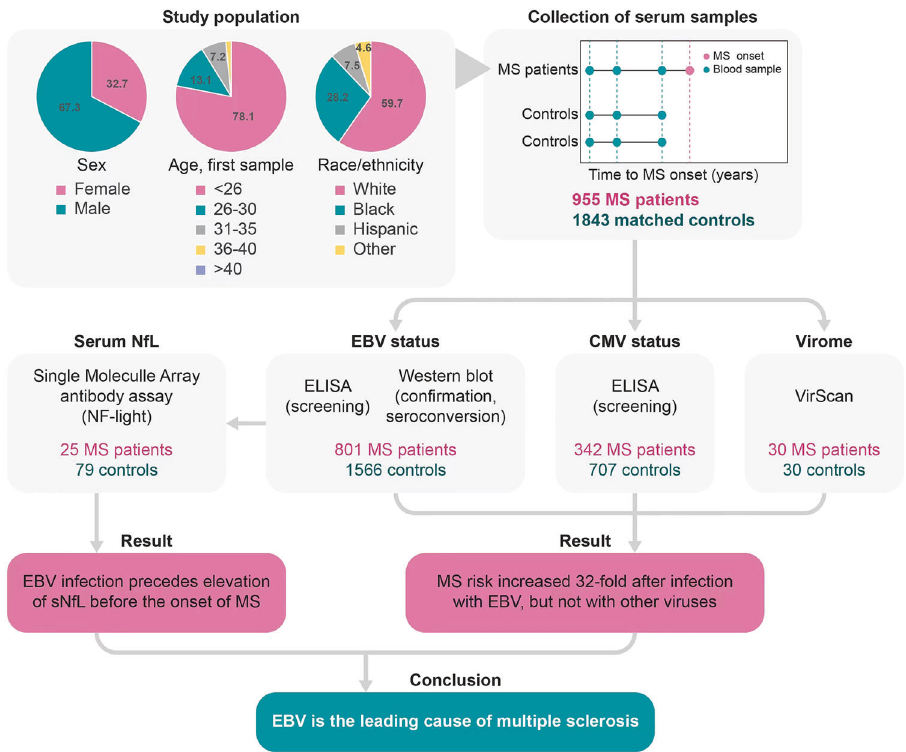
Fig. 1 Schematic illustration of the study. Samples from 955 MS case and 1843 controls were randomly selected in the following experiments. Individuals were assessed for EBV and CMV status by three serum samples per person. Serum sNfL levels were measured before, around, and after the time of EBV infection in individuals whose fi rst serum sample was EBV-negative. Virome analysis of serum samples from 30 MS cases and 30 match was made by VirScan. These experiments suggest that EBV is the leading cause of multiple